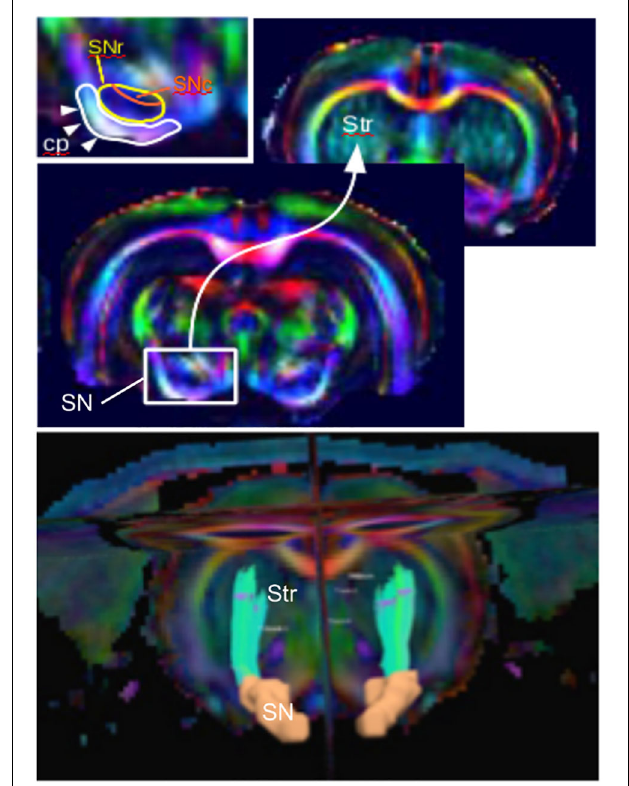
FIGURE 2 | The nigrostriatal pathway illustrated with color-coded diffusion tensor images of a rat brain (coronal views). (Top) Zoom into the subtantia nigra (SN) projection to the striatum (Str) and inlet showing the detailed structure with the cerebral peduncle (cp), the SN reticulata (SNr), and the SN compacta (SNc). (Bottom) Three-dimensional reconstructed nigrostriatal tract (green) from the SN (orange) to the dorsal Str using diffusion-based